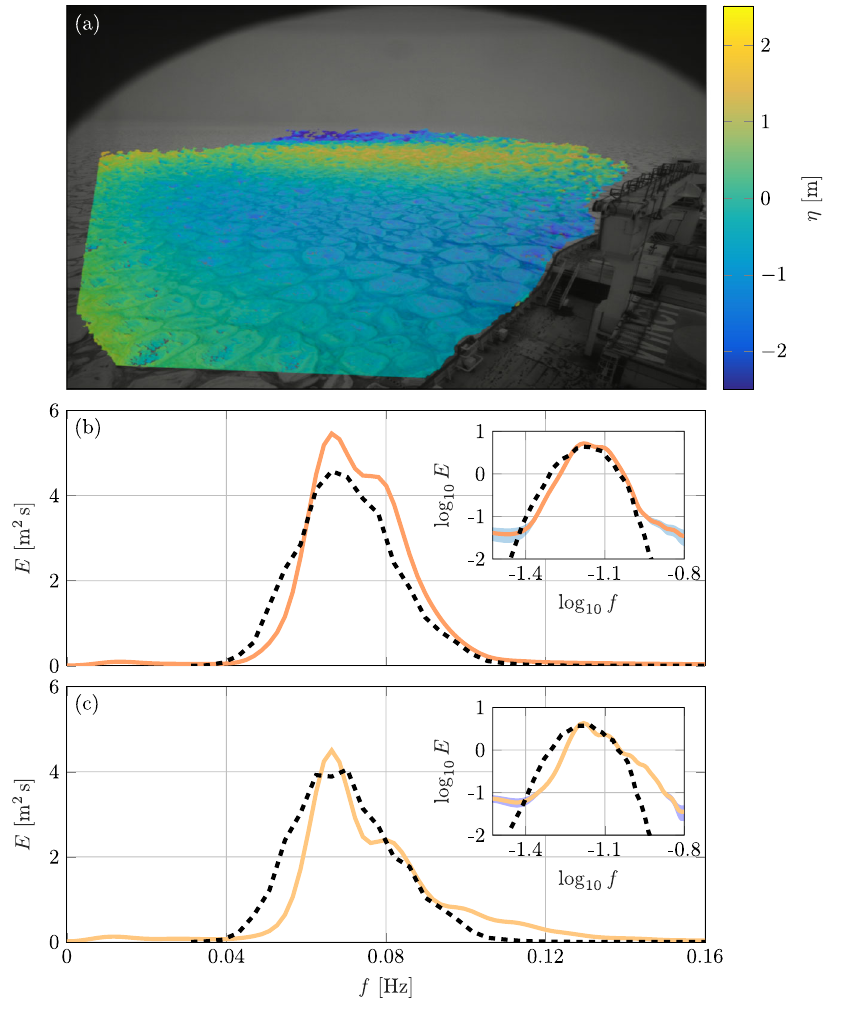
Fig. 3 | Three-dimensional surface elevation retrieval and validation against buoys.a Reconstructedsurfaceelevation, η (axesinpixels). b , c Frequencyspectra were obtained from the surface elevations measured at the two deepest mea- surement locations ( d =43 – 44km; solid curves) and co-located buoy